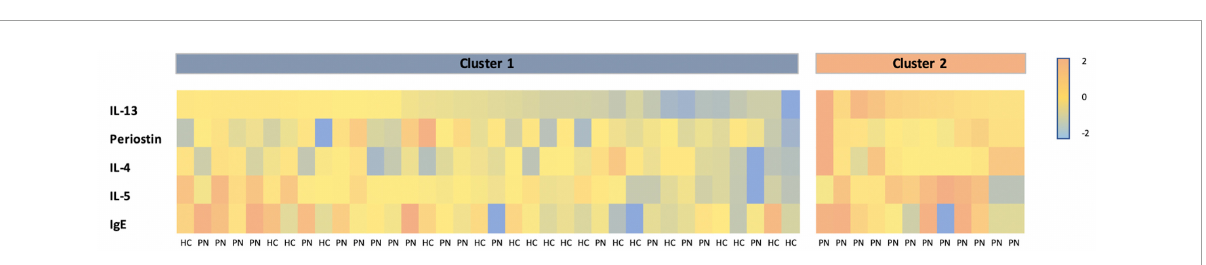
FIGURE3 Heatmap of Z -scored biomarker levels for each patient, delineated by cluster. PN, prurigo nodularis; HC, healthy